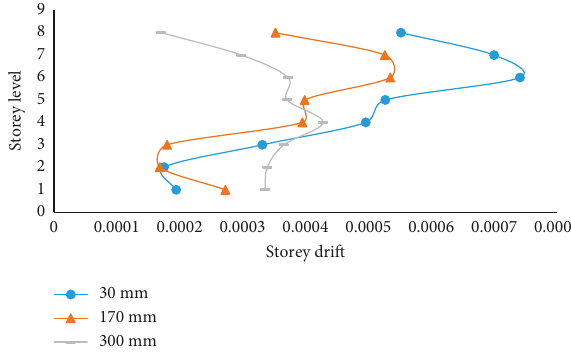
Figure 23: Storey drift in each floor level for different separation